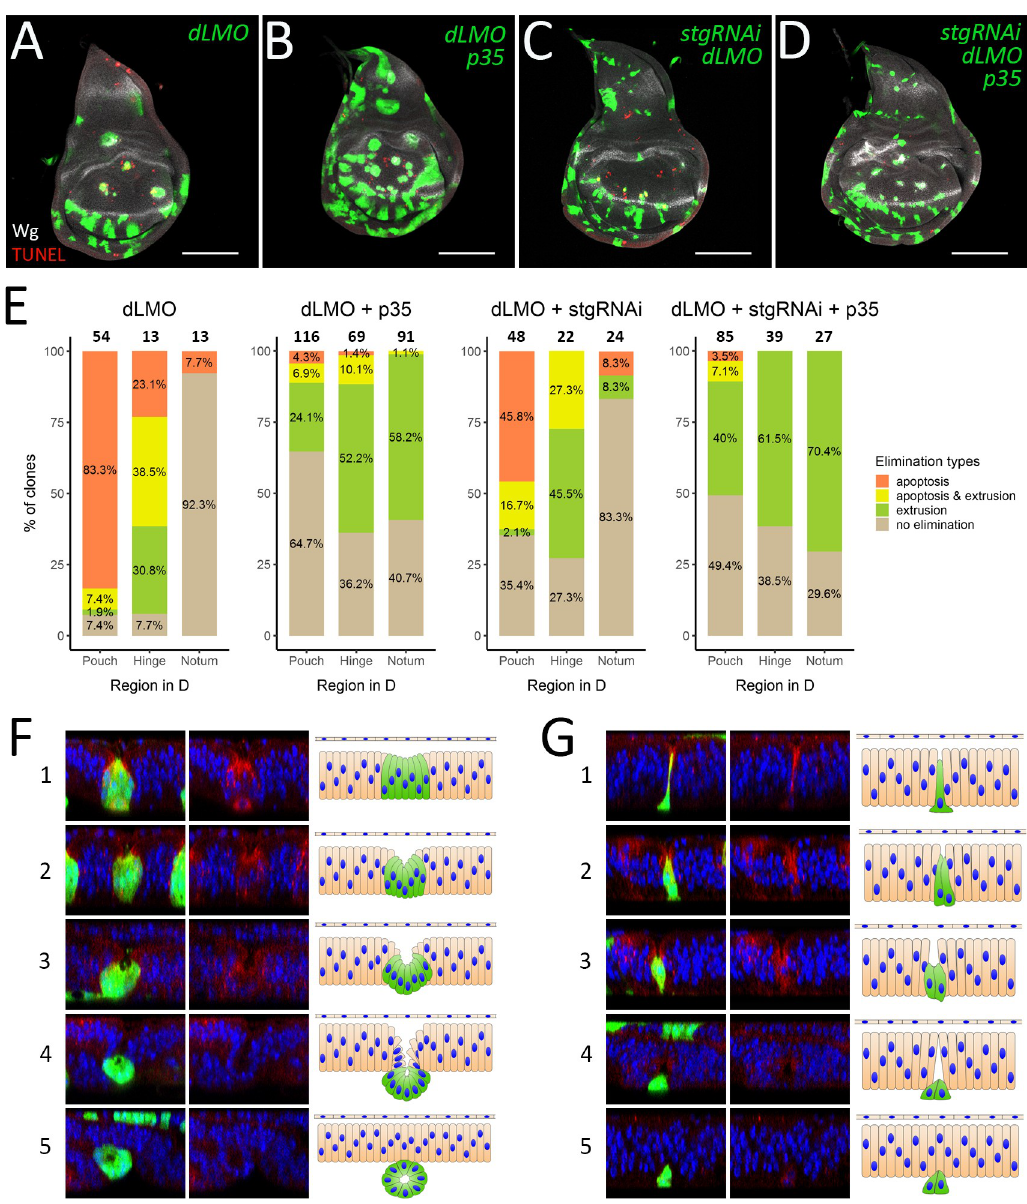
Fig 6. Clone size reduction does not prevent clone extrusion. (A-D) Third instar wing discs containing dLMO (A), dLMO+p35 (B), stgRNAi+dLMO (C) and stgRNAi+dLMO+p35 (D) clones. (E) Quantification of clones of the indicated genotypes in different regions of dorsal compartment depending on the evidence of elimination type: apoptosis, extrusion or apoptosis together with extrusion. The numbers of analyzed clones in each region are displayed above the bars. (F-G) Extrusion of large and small clones. Examples of large ( dLMO+p35 ) (F) and small ( stgRNAi+dLMO+p35 ) (G) misspecified clones at different stages (1–5) of extrusion process. XZ cross-sections throughout the clones are shown (orientation: the apical side–up). The left panel: clones in green, nuclear staining (Dapi) in blue, Wg staining in red; the middle panel—nuclear and Wg staining alone; right panel–schematic representation of morphological changes. The initial steps of extrusion of both large and small clones involve apical constriction and reduction of cell height (cell shortening) from the apical side (F and G, 1–2). Propagation of those processes, especially cell shortening, in case of large clones leads to cyst formation, where apical sides of clonal cells face the newly-formed cavity (F, 3–4). In contrast, small clones do not form cysts, although the cells reduce their height further and get extruded from the tissue (G, 3–4). Finally, the wild-type neighboring cells fuse above the clones and restore epithelial integrity (F and G, 5). Scale bars represent 100 μ